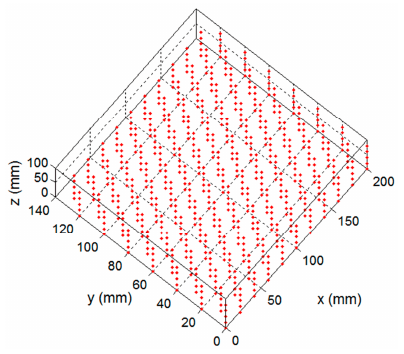
Figure 15. The measured distances in a 420 × 150 × 100 mm volume.